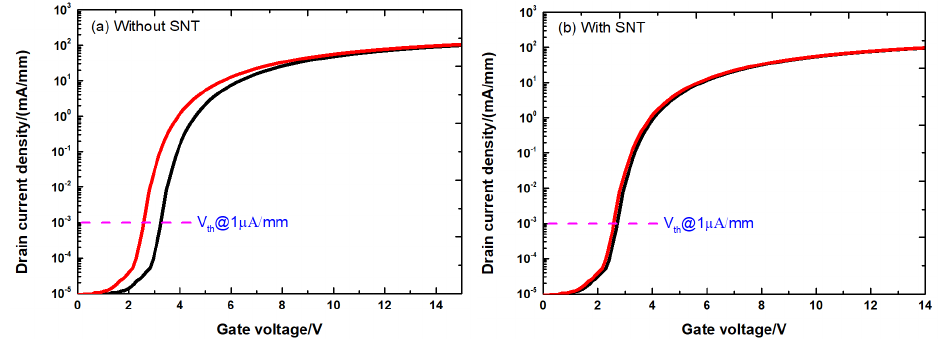
Figure 4. Transfer curves of the all-GaN integrated MIS-HEMTs in didiretional V GS 15 V and then back to 0 V ( a ) without SNT and ( b ) with